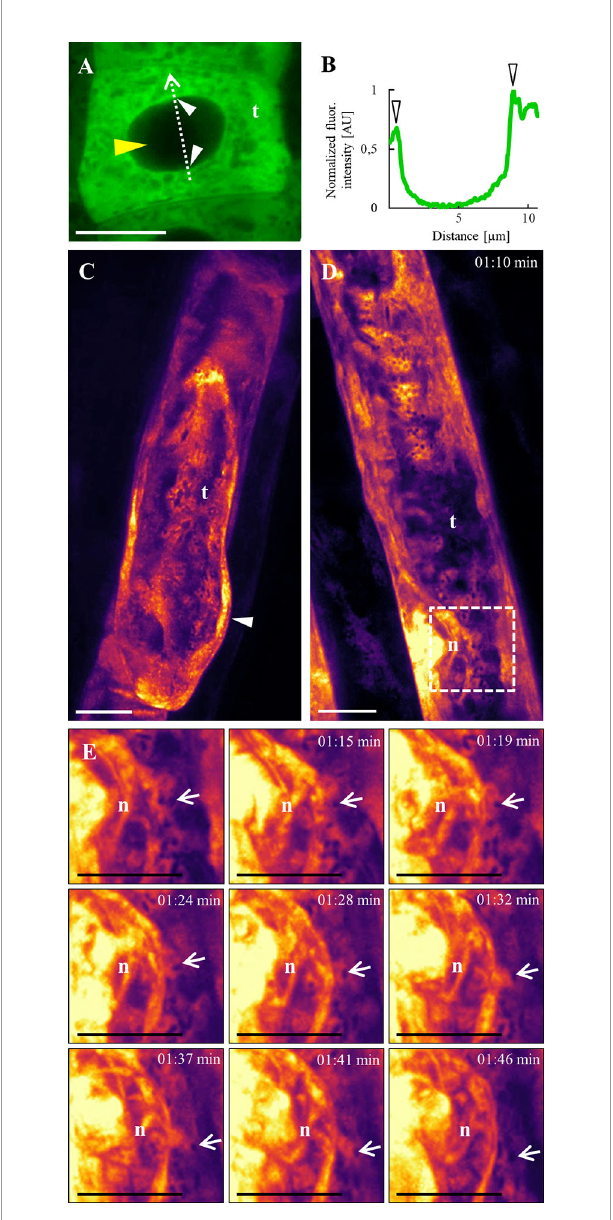
FIGURE 7 | Subcellular localization of ANN1-GFP in trichoblasts using Airyscan CLSM (A, B) and lattice LSFM (C – E) . (A) Accumulation of ANN1- GFP around the nucleus, close to the nuclear envelope (white arrowheads) in trichoblast (t) cell within meristematic root zone. Note the absence of ANN1- GFP fl uorescence in the nucleus indicated by the yellow arrowhead. (B) Fluorescence intensity pro fi le of ANN1-GFP distribution was measured along a dotted arrow in (A) and normalized. Note that arrowheads indicate maximum of measured fl uorescence intensity corresponding to ANN1-GFP accumulation around the nuclear envelope. (C – E) In vivo time-lapse imaging of ANN1-GFP localization in trichoblasts using lattice LSFM. (C) Higher fl uorescence intensity of ANN1-GFP at the basal end of trichoblast (t) and its accumulation in the cortical cytoplasm of the established bulge (white arrowhead). (D) Accumulation of ANN1-GFP around the nucleus (n), close to the nuclear envelope in elongating trichoblast (t). (E) Magni fi ed boxed area in (D) showing selected stills of vesicular dynamic movement (arrows) around the nucleus (n) of elongating trichoblast. Scale bars = 10 m